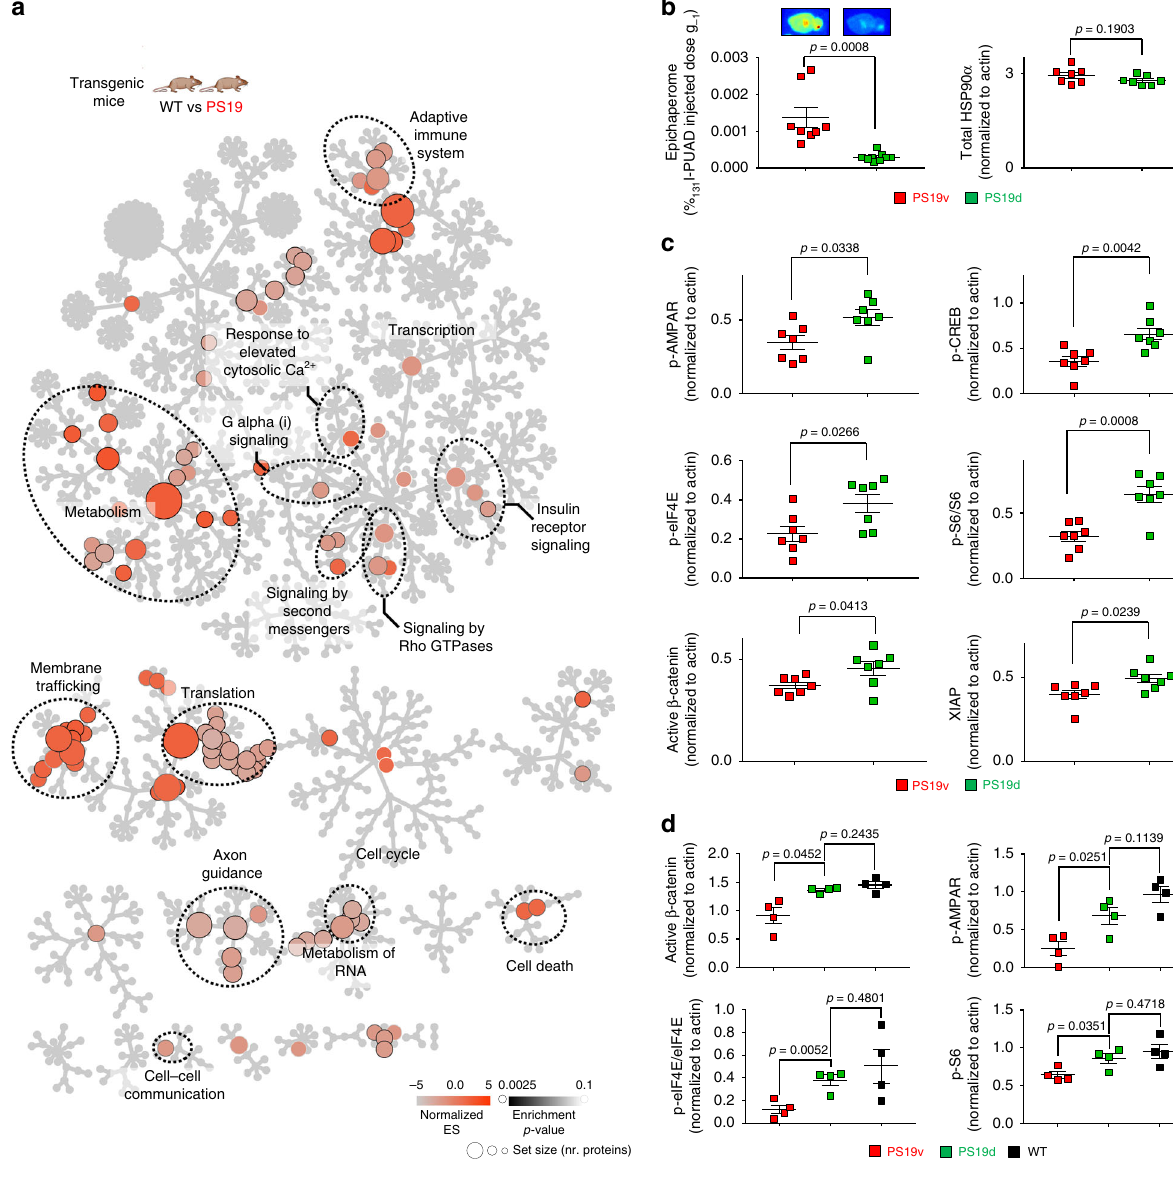
Fig. 7 Epichaperome inhibition corrects the activity of synaptic protein networks in PS19 mice. a Reactome pathway analysis shows the identity of epichaperome-mediated alterations in protein pathways intrinsic to PS19 mice. b Co-injection of PU-AD and tracer amount of 131 I-PU-AD con fi rms target engagement in PS19 brains by PU-AD. Graph, mean ± SEM, unpaired two-tailed t -test, n = 8 for vehicle treated PS19 (PS19v) and n = 9 for PU-AD treated PS19 mice (PS19d). c Western blot of PS19 treated mice monitoring effects of protein pathways as in ( a ). We measured several effectors in the function of synaptic pathways: p-AMPAR Ser845, p-CREB Ser133 and active β -catenin. p-S6 and p-eIF4E are both key effectors linking insulin receptor signalling, via mTOR and other upstream signalling pathways, to translation initiation. XIAP is a potential inhibitor of neuronal apoptosis. Graph, mean ± SEM, unpaired two-tailed t -test, n = 7 PS19v, n = 7 PS19d. Mice were sacri fi ced 48 h post-last injected dose. See also Fig. 8a and Supplementary Fig. 5A. d A rebalance in the function of synaptic protein pathways to levels observed in WT mice was observed in PS19 mice treated with PU-AD. Graph, mean ± SEM, unpaired two-tailed t -test with Welch ’ s correction, n = 4 PS19v, n = 4 PS19d and n = 4 WT. Mice were sacri fi ced 24 h post-last injected dose. See also Fig. 8a and Supplementary Fig. 5B. Source data are provided as a Source Data fi